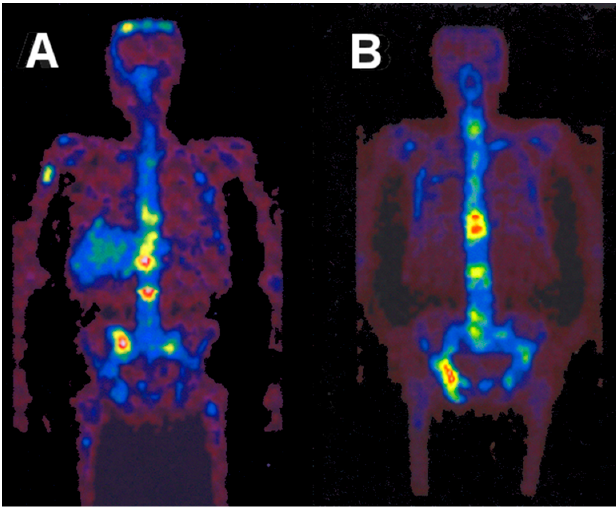
Figure 13. Whole-body images of the distributions of 86 Y-citrate ( A ) and 86 Y-EDTMP ( B ) at 22 h p.i. The anterior view images are summations of all coronal slices.